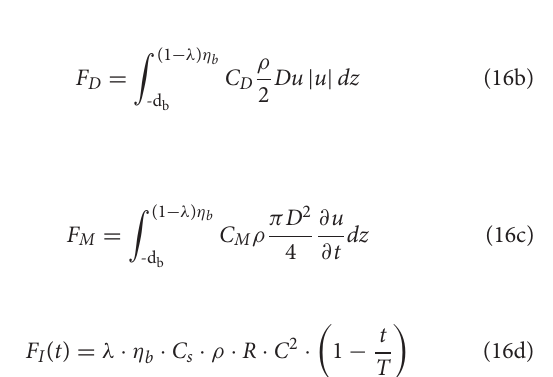
FIGURE 5 | OC5 project: (A) Side view of the water tank and cylinder location. (B) Compare numerical simulation results to OC5 model test